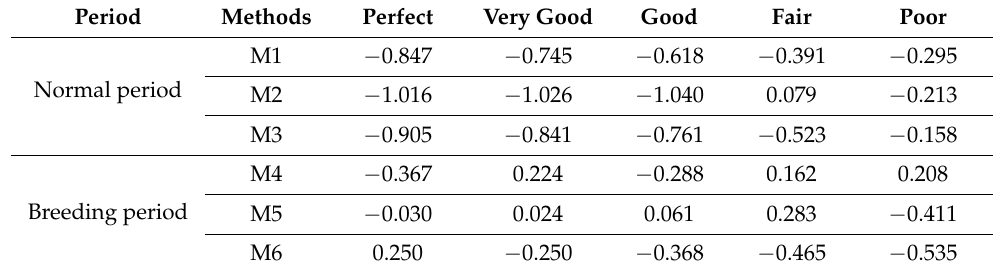
Table 8. The correlation degree between the calculated results of different methods. Period Methods Perfect Very Good